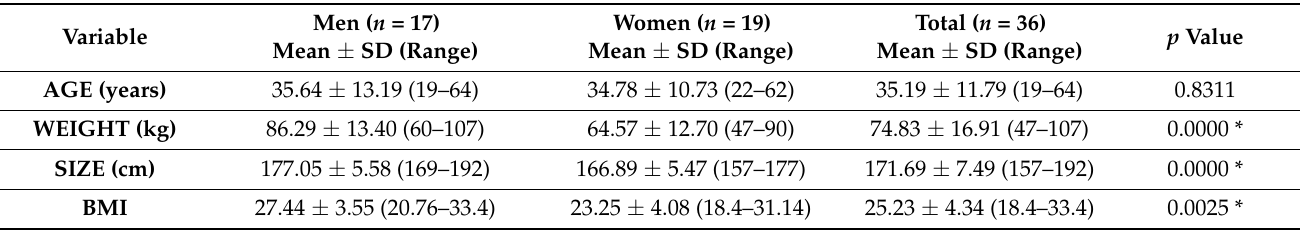
Table 1. Demographic data of the